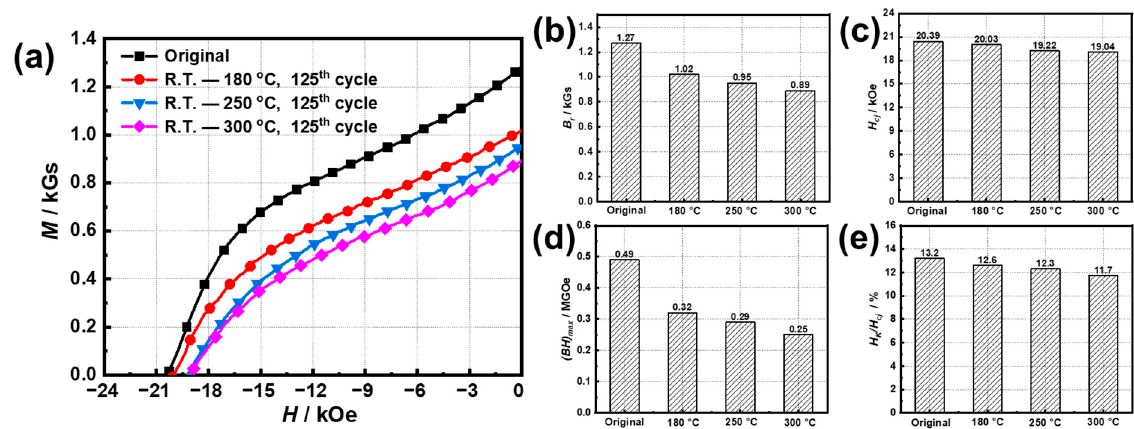
Figure 2. Variation trends of ( a ) Φ , and ( b ) the loss of Φ of the samples cycled in ranges of R.T. to 180, 250, and 300 °C, respectively. The line in ( b ) are the fitting curves with a formula Y = A × (X − X c ) P .